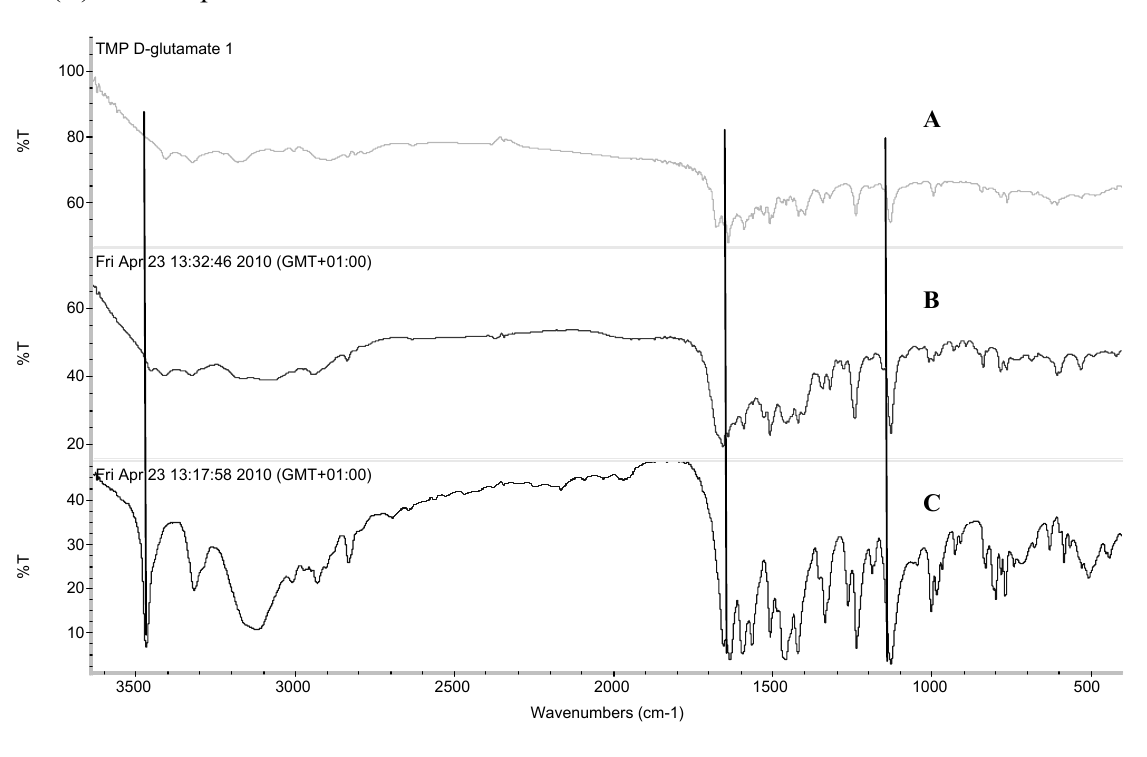
Figure 4. FTIR spectra of (A) trimethoprim D -glutamate, (B) trimethoprim L -glutamate and (C)